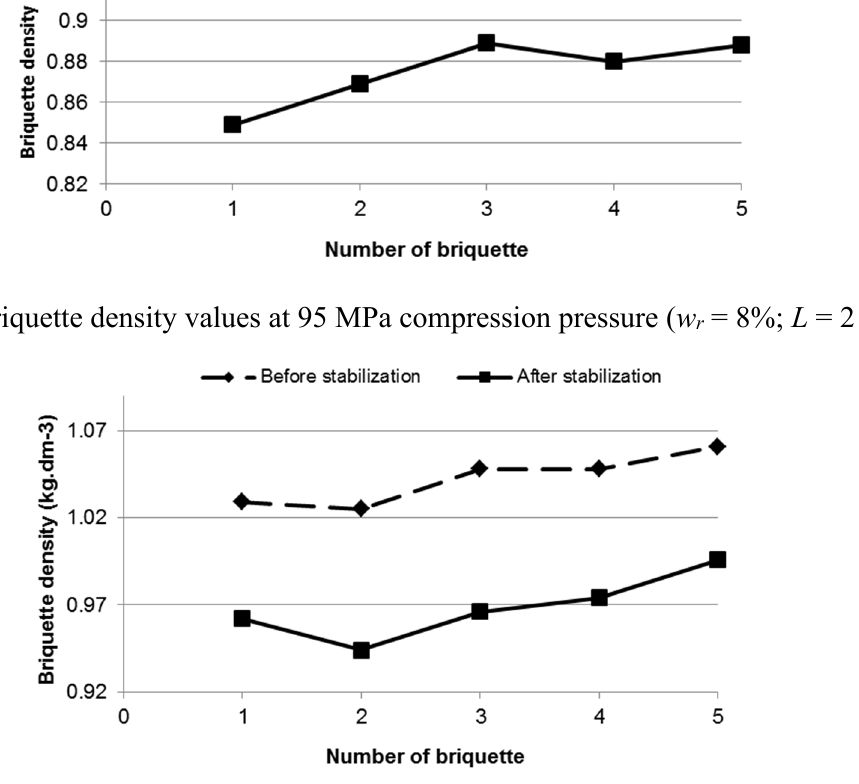
Figure 7. Briquette density values at 159 MPa compression pressure ( w r = 8%; L = 2 mm).